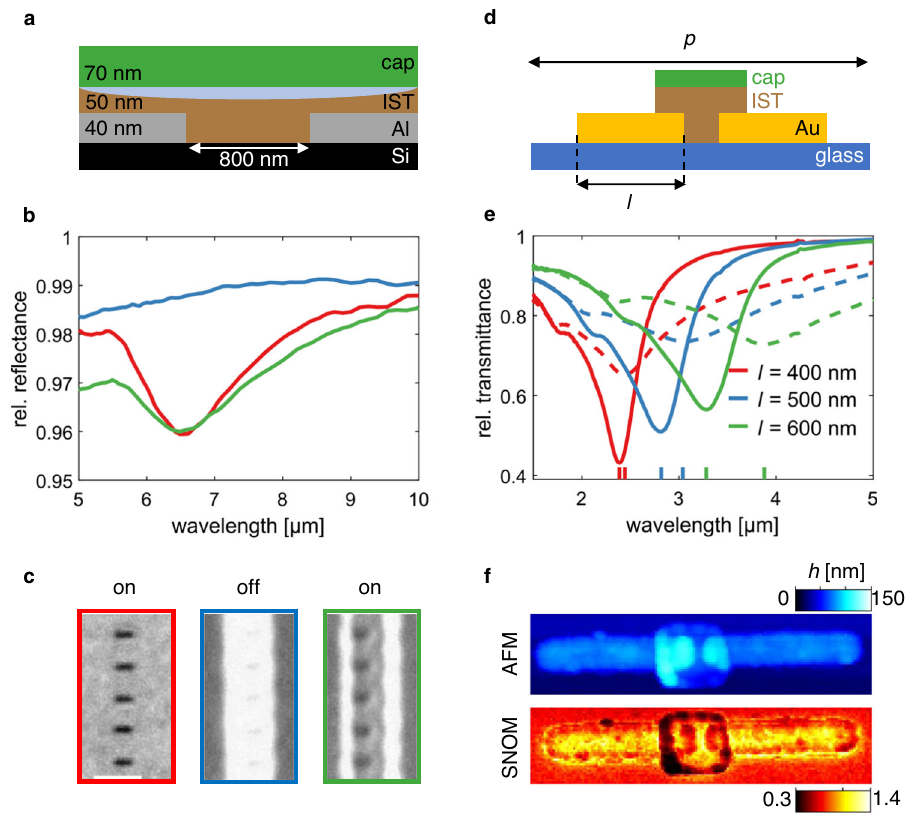
Fig. 5 Nanoscale screening and soldering of nanoantennas with In 3 SbTe 2 . a Cross-section sketch of the full layer stack of an IST-covered Al slit antenna. The cIST (light blue) does not reach down completely through the aIST (brown) to the Al (silver). b FTIR re fl ectance spectra of slit arrays for the default on- state (red), the off-state (blue) and the restored on-state (green). c Light microscope image excerpts of the arrays measured in b (scale bar: 2 µ m). d Cross- section sketch of the array unit cell with a gold dimer antenna on glass whose gap is bridged with an IST patch. e Measured transmittance spectra of the dimer antenna arrays with different antenna lengths l (400nm, 500nm, 600nm) and period p = 2.4 l for aIST (solid) and cIST (dashed). With cIST the dimers are soldered together and the resonance redshifts (see colored ticks at the bottom). f AFM (top) and s-SNOM (bottom) images of a gold dimer soldered together with cIST: In the s-SNOM image, the cIST patch has the same optical contrast as the Au antennas, verifying its metallic infrared optical